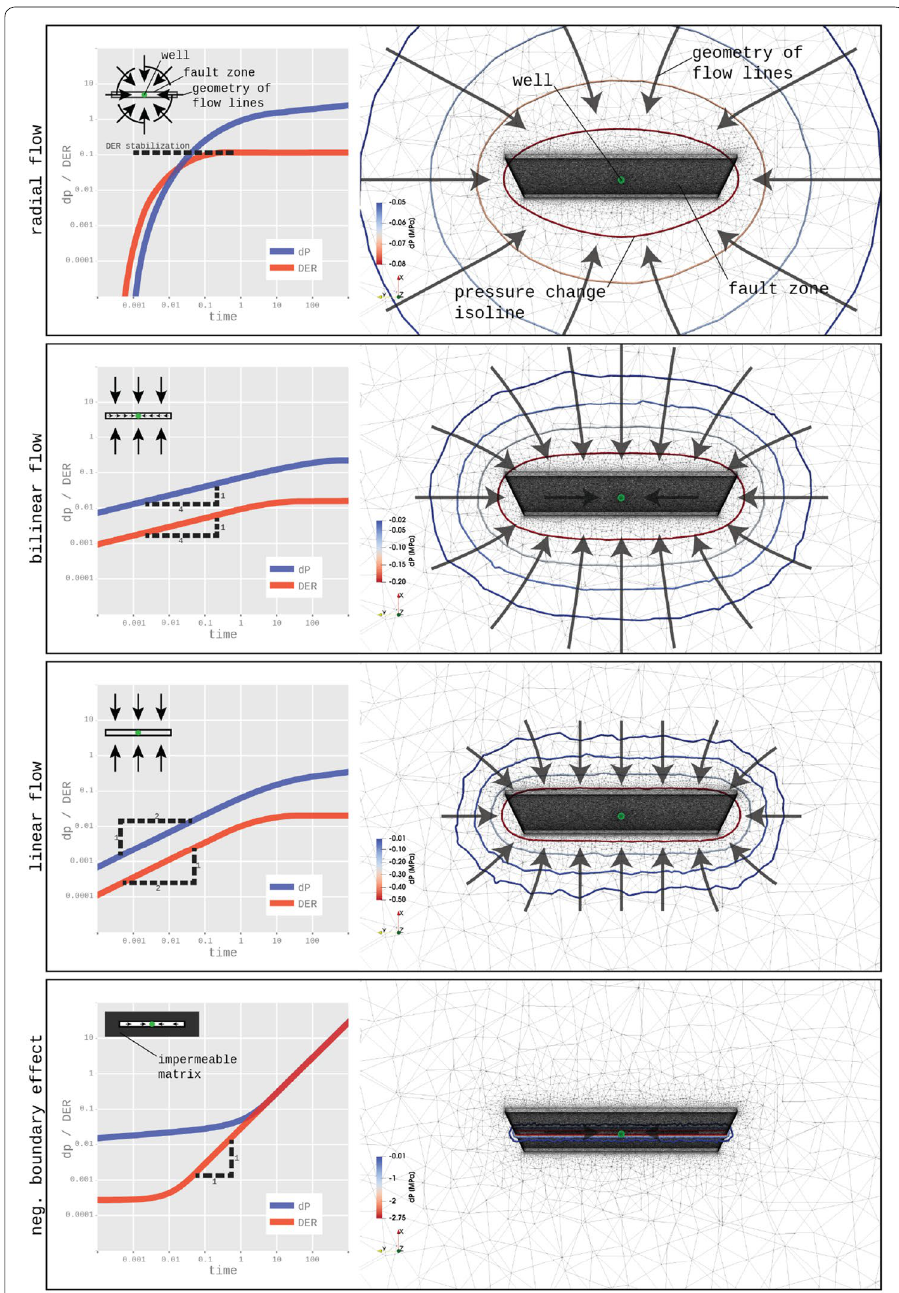
Fig. 1 Flow regimes connected to fault zones; left: pressure change (dP) of idealized pumping test, associated Bourdet derivative and concept of flow field, see also Table 2 for a summary; right: representative example during presence of each flow regime in the complex geometry of the 3D numerical model, numerically calculated pressure change isolines around the fault